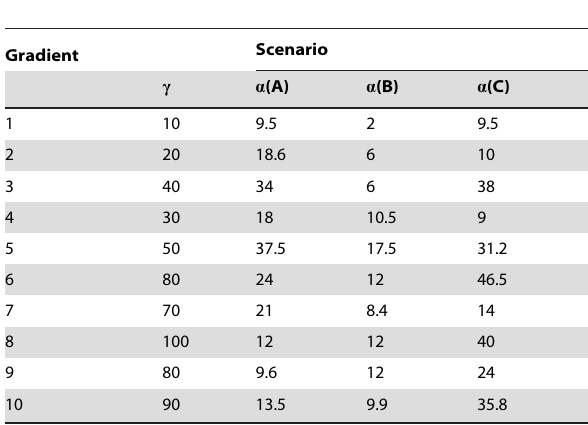
Table 2. Values of c - and a -diversity along a hypothetical ecological gradient for three scenarios.